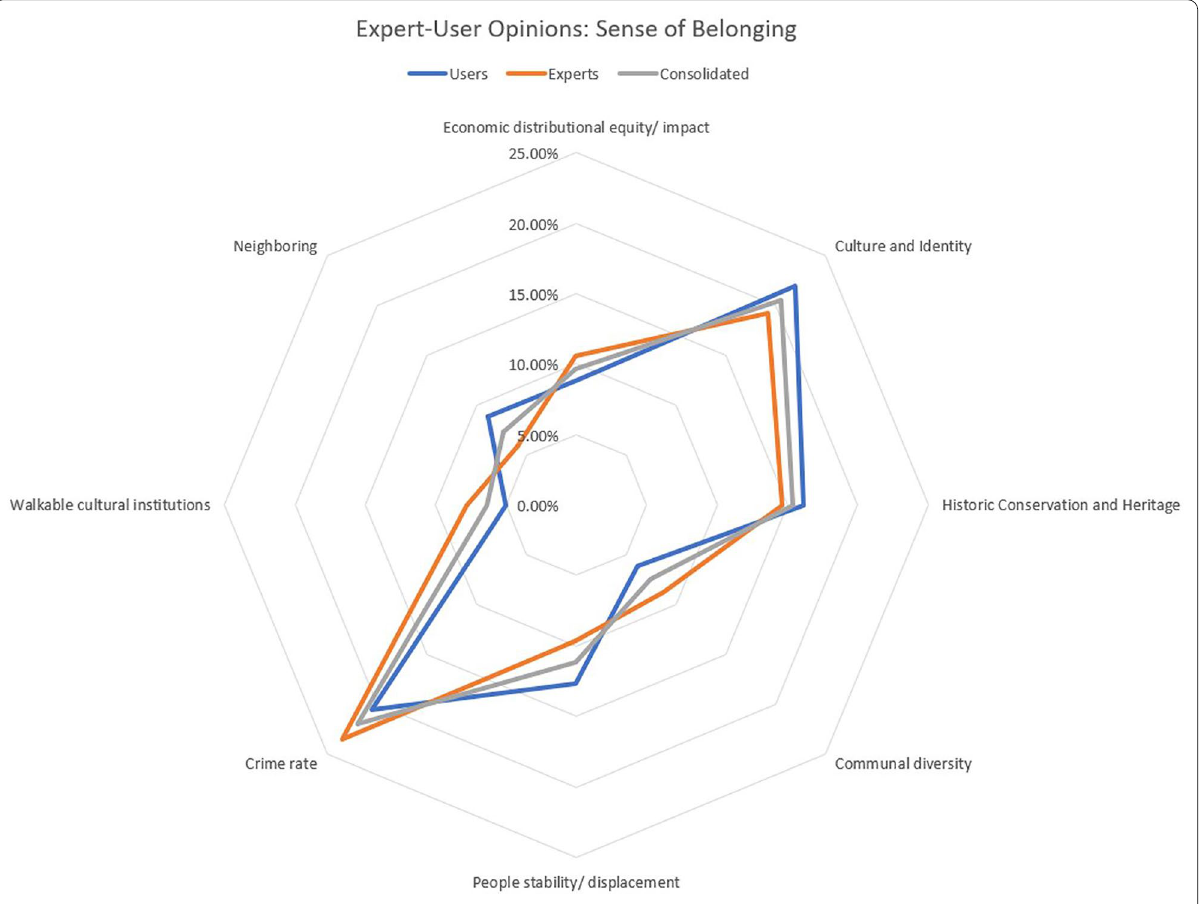
Fig. 8 Comparison between experts and users’ opinions—sense of belonging